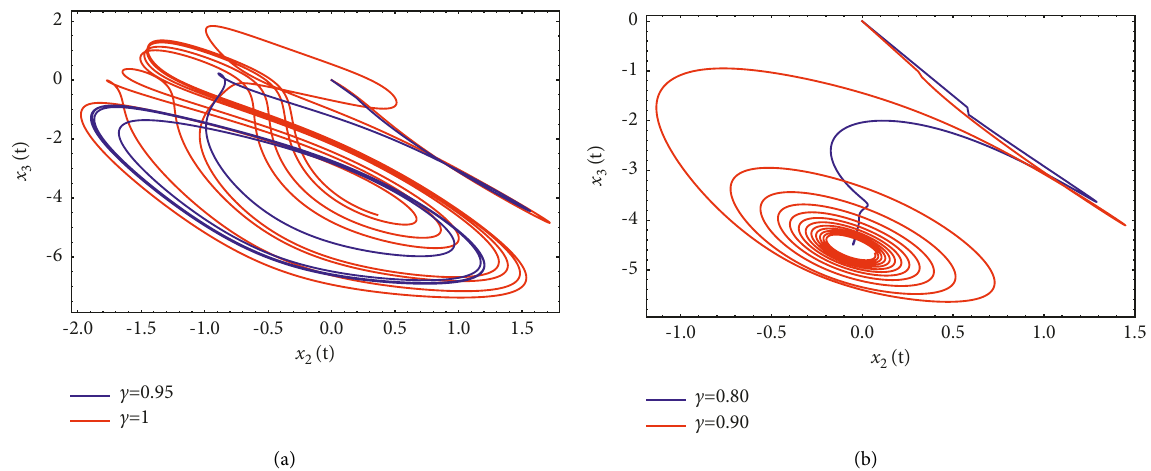
� 1 . 15 and x ( 0 ) � 2 , x ( 0 ) � x ( 0 ) � 0 at different fractional orders. 1 2 3 2